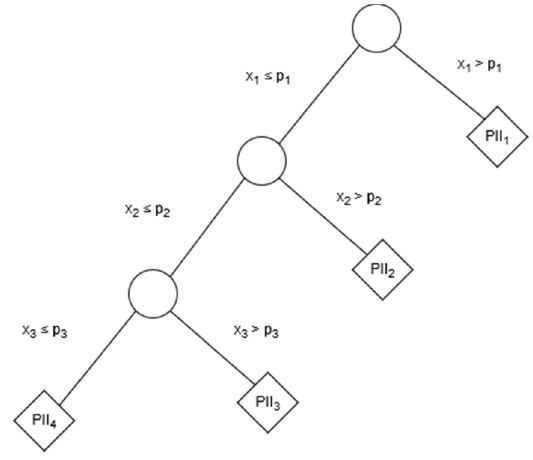
Figure 10. Probability of revealing a PII.